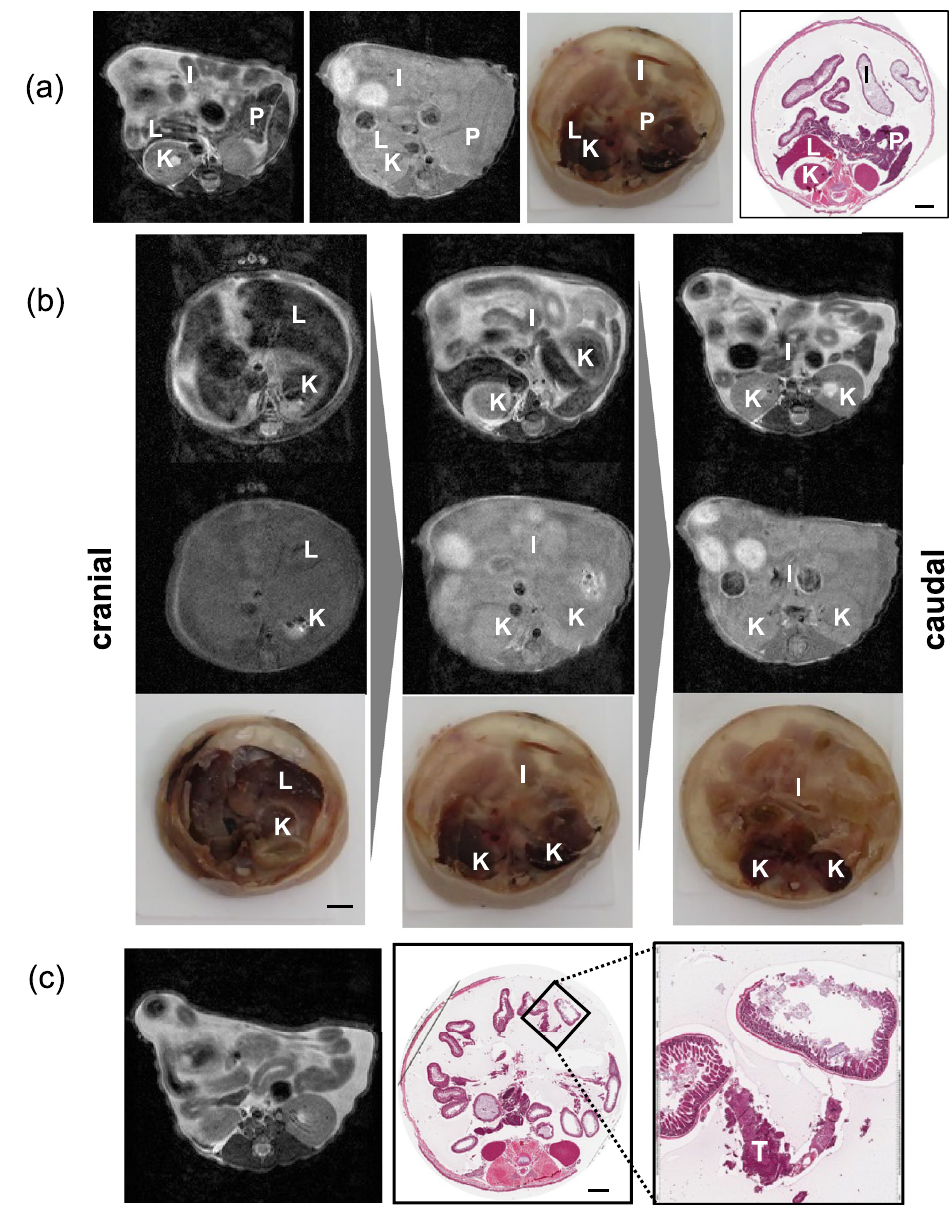
Figure 2. ( a ) Preservation of spatial information in the sectioned slides. Magnetic resonance imaging (MRI) images [left: T2-weighted image (T2WI); right: T1-weighted image (T1WI)], sectioned organs, and macro images of hematoxylin and eosin (H&E)-stained section specimens from nude BALB/c mice with ES-2 ovarian cancer dissemination are shown. I Intestine, K kidney, L liver, P pancreas, S spleen. Scale bar: 2 mm. ( b ) Sequential MRI images [upper images: T2-weighted images (T2WIs); lower images: T1-weighted images (T1WIs)] and sectioned organs at the same anatomical level as the MRI images. Scale bar: 2 mm. ( c ) Comparison between the spatial information obtained using MRI and that obtained from the sectioned slides created using our method. A disseminated small nodule (inset, T) was visible in the sectioned slide. Scale bar: 2